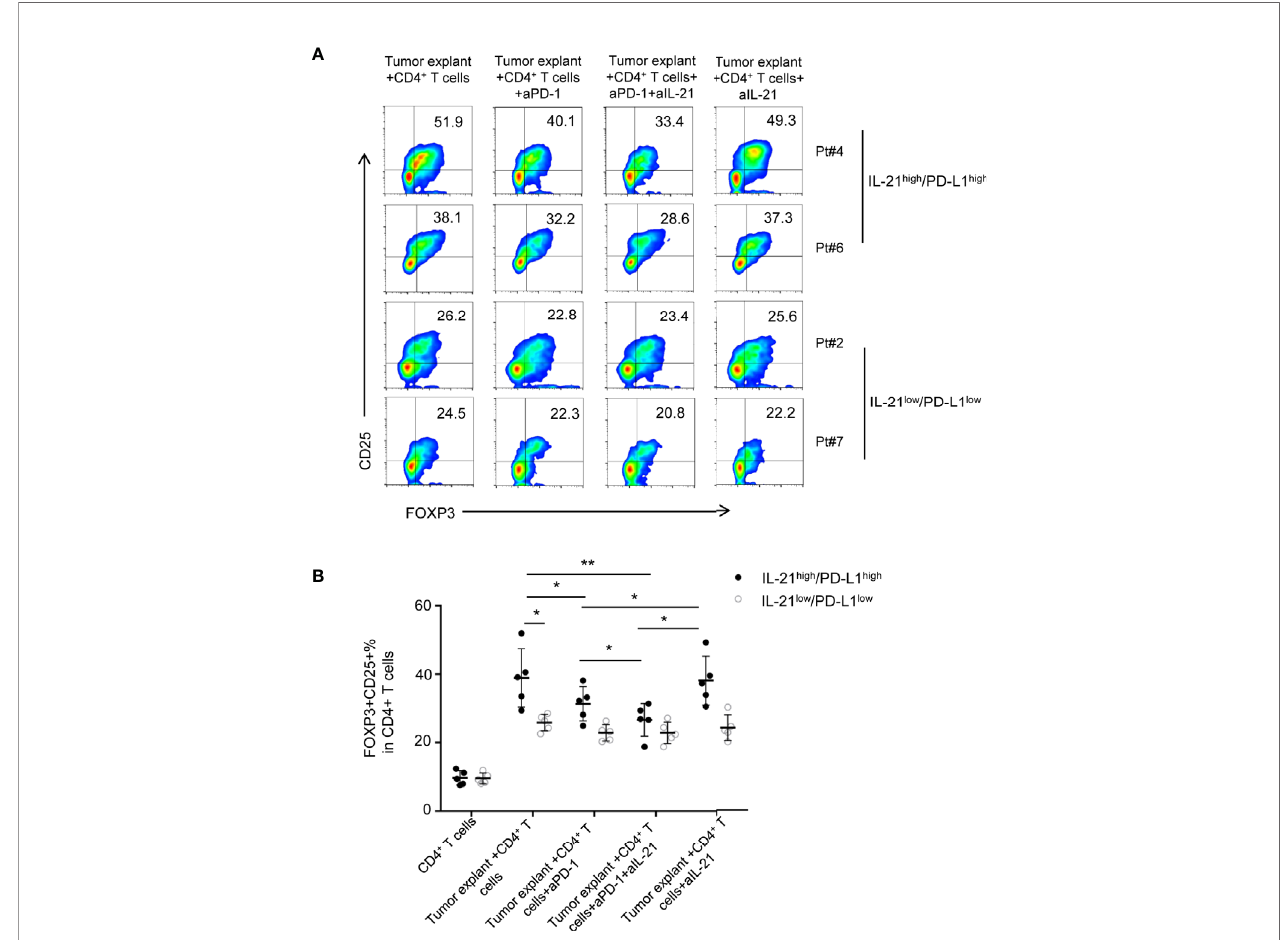
FIGURE 5 | Neutralizing IL-21 enhances the blocked effect of PD-1 antibody on Treg generation induced by IL-21 high /PD-L1 high tumor explants. (A) Tumor explants from 10 patients with HNSCC were divided into 2 groups according to the cutoff points of PD-L1 and IL-21. Effect of HNSCC tumor explant on Treg induction was assessed by culturing tumor explants and CD4 + T cells isolated from peripheral blood in the presence or absence of IL-21 and/or PD-1 neutralization antibody. (B) Quanti fi cation of percentage of FOXP3 + CD25 + Tregs was shown (n = 5, *P < 0.05, **P < 0.01, by Student ’ s